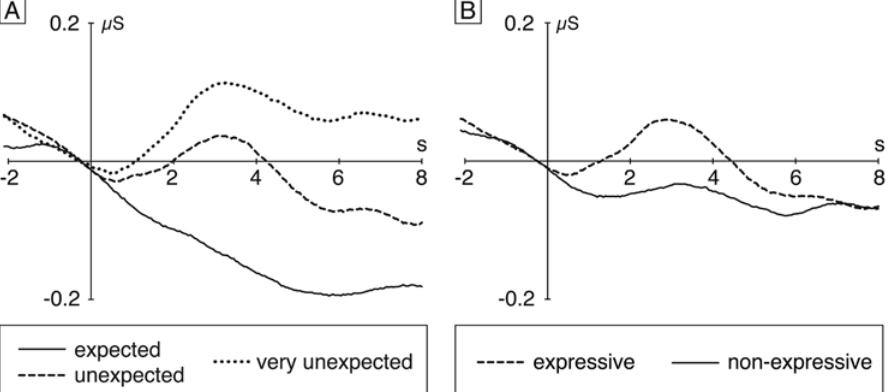
Figure 3. Skin conductance responses (SCRs). A: Grand-average of SCRs elicited by expected, unexpected (original), and very unexpected chords (averaged across expressive and non-expressive conditions). Compared to expected chords, unexpected and very unexpected chords elicited clear SCRs. Notably, the SCR elicited by very unexpected chords was larger than the SCR to unexpected (original) chords, showing that the magnitude of SCRs is related to the degree of harmonic expectancy violation. B: Grand-average of SCRs elicited by expressive and non-expressive chords (averaged across expected, unexpected, and very unexpected conditions). Compared to non-expressive chords, chords played with musical expression elicited a clear